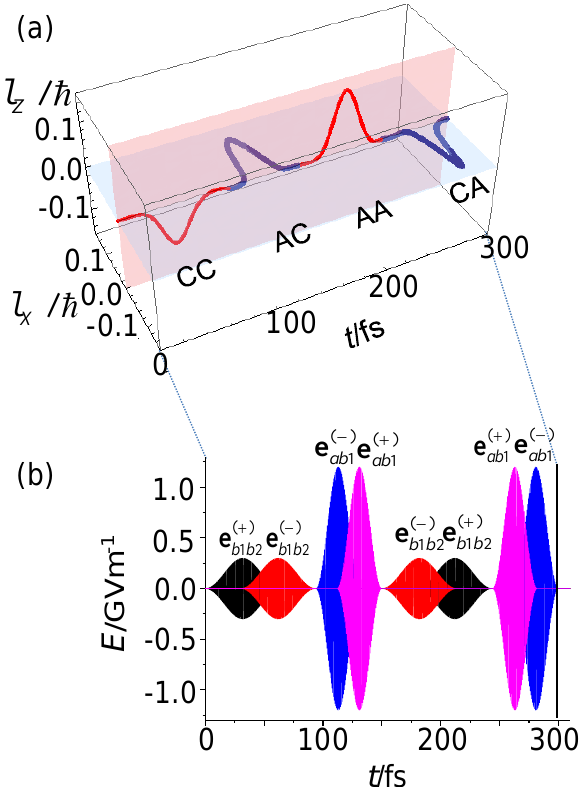
Figure 13. ( a ) Sequential four-step switching of π-electron rotations in ( P )-2,2′-biphenol. ( b ) Electric fields of the sequence of overlapped pump and dump pulses. Reprinted from [86] with permission of the American Chemical Society.